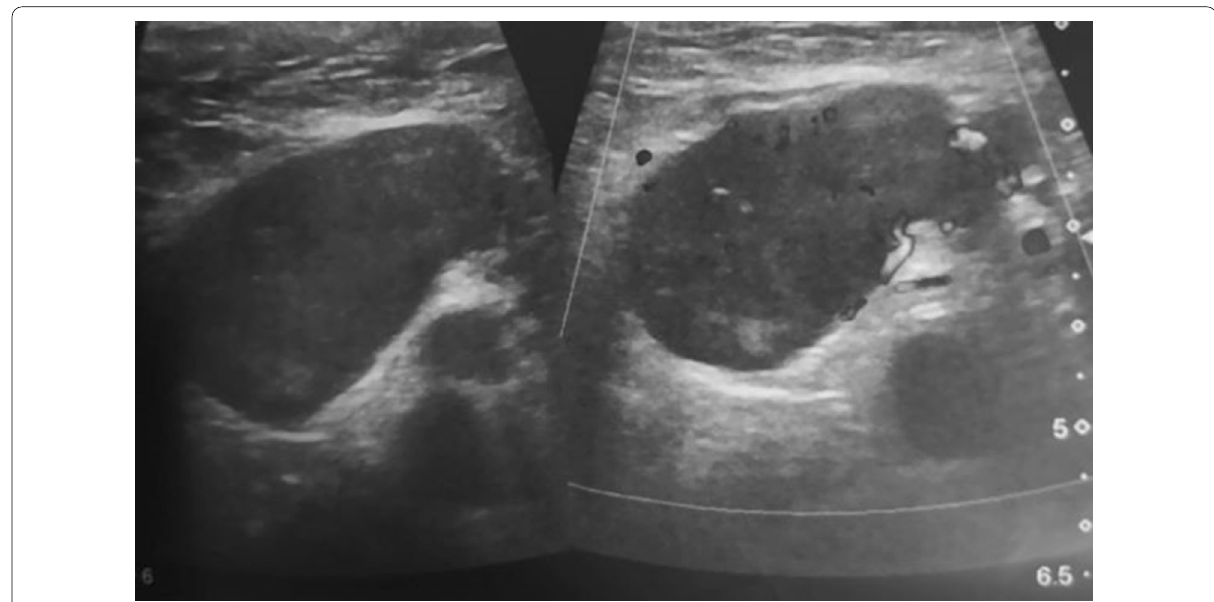
Fig. 2 Ultrasound of right axilla: Enlarged malignant looking lymph nodes in right axilla. Complete effacement of fatty hilum is seen in all the visualized lymph nodes. Doppler flow is seen in hilum as well as in the abnormally thickened cortex. Associated perinodal edematous changes also